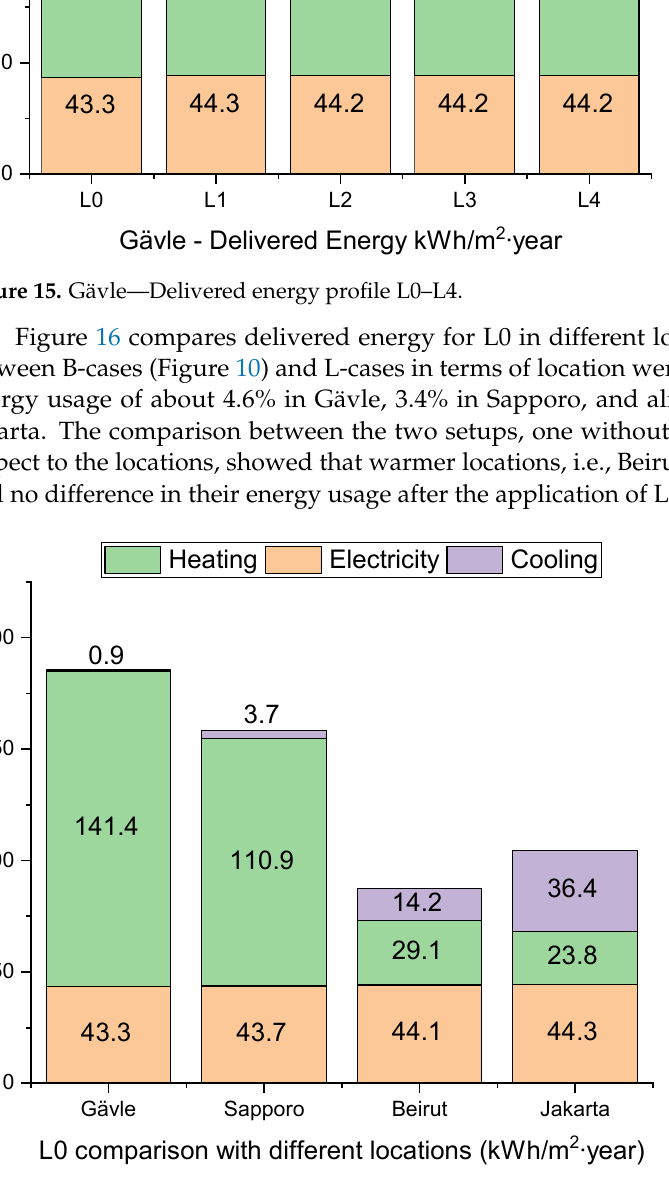
Figure 16. Comparison between energy usage for L0 in different locations.